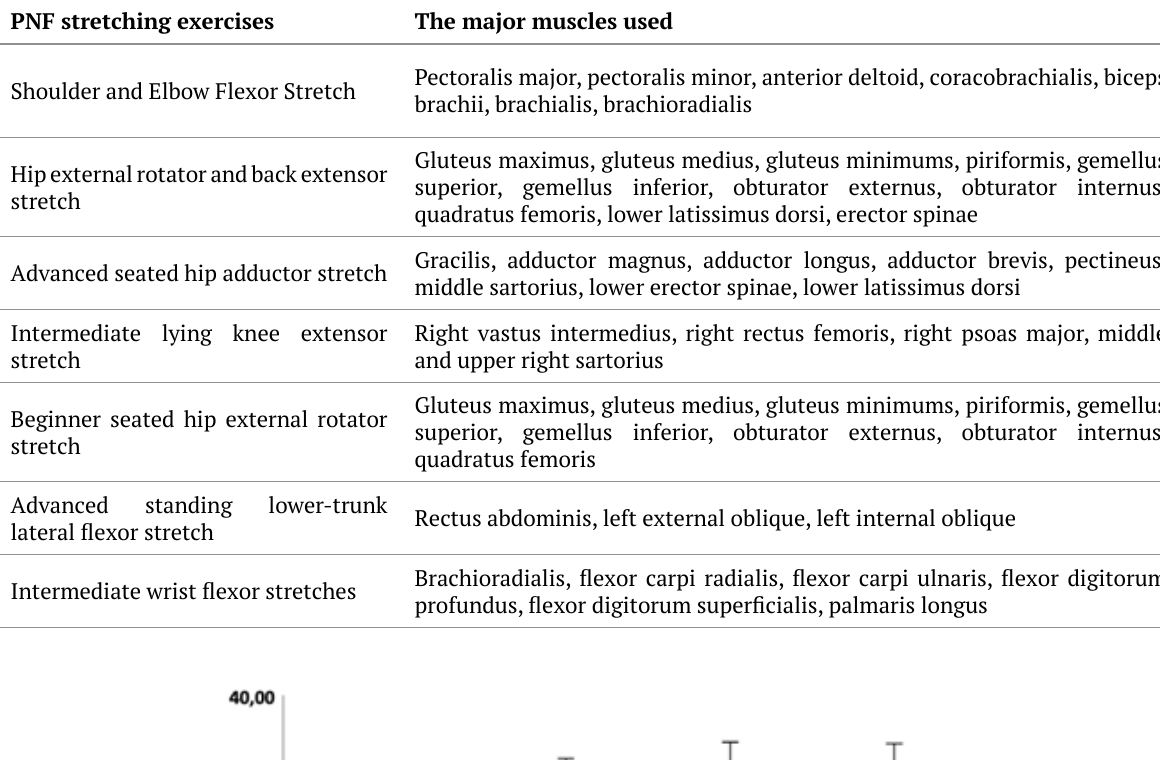
Table 1. PNF stretching exercises and the major muscles used PNF stretching exercises